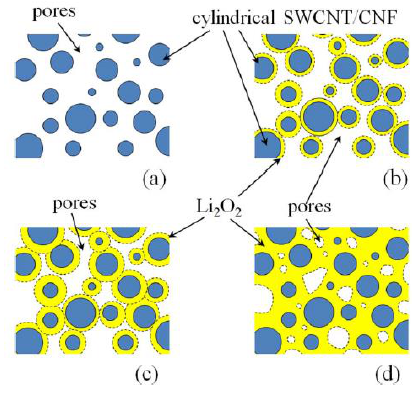
Figure 7. Formation of a lithium peroxide layer on the surface of SWCNTs and CNFs. ( a ) Pristine cathode; ( b , c ) during the first part of the discharge; and ( d ) at the final part of discharge. Republished from Chen et al. [19] with permission of the Electrochemical Society, conveyed through Copyright Clearance Center, Inc.